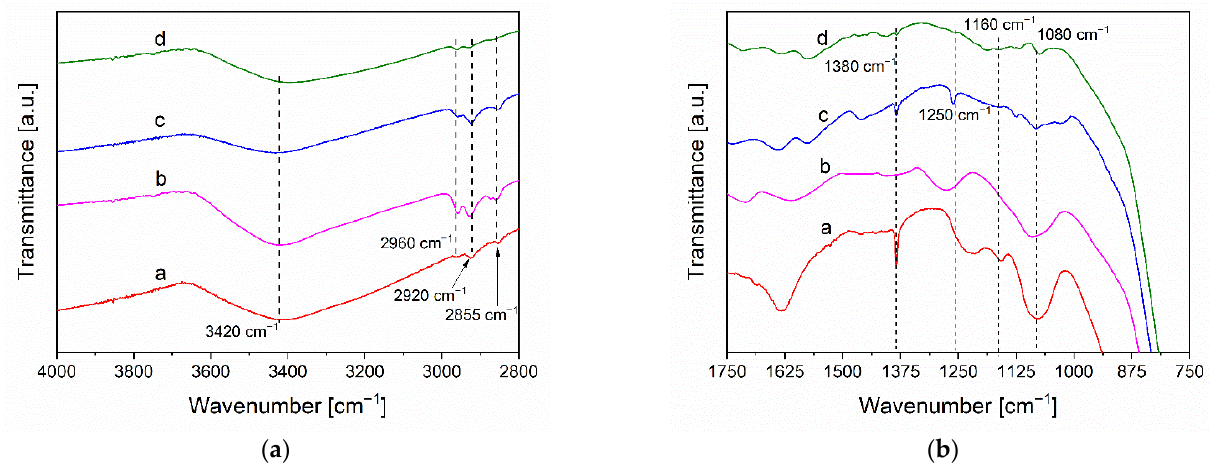
Figure 3. FTIR spectra of: a- TiO 2 -GO (red line) b- TiO 2 -rGO thermal (magenta line); c- TiO 2 -rGO solar (blue line) and d- TiO 2 -rGO UV (olive line). The spectra are separated in two graphs in order to facilitate the reading: ( a ) region from 4000 to 2750 cm − 1 , ( b ) region from 1750 to 750 cm − 1.